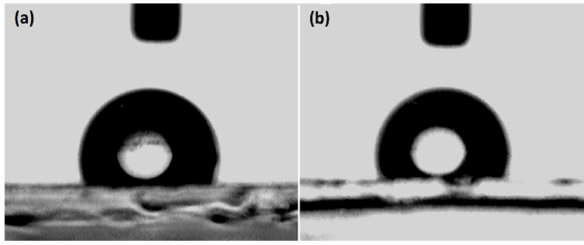
Figure 7. Photographs taken during static water contact angle measurements: ( a ) fluorinated polyurethane coating, ( b ) poly(CTFE-alt-BVE) coating (Sample P4).